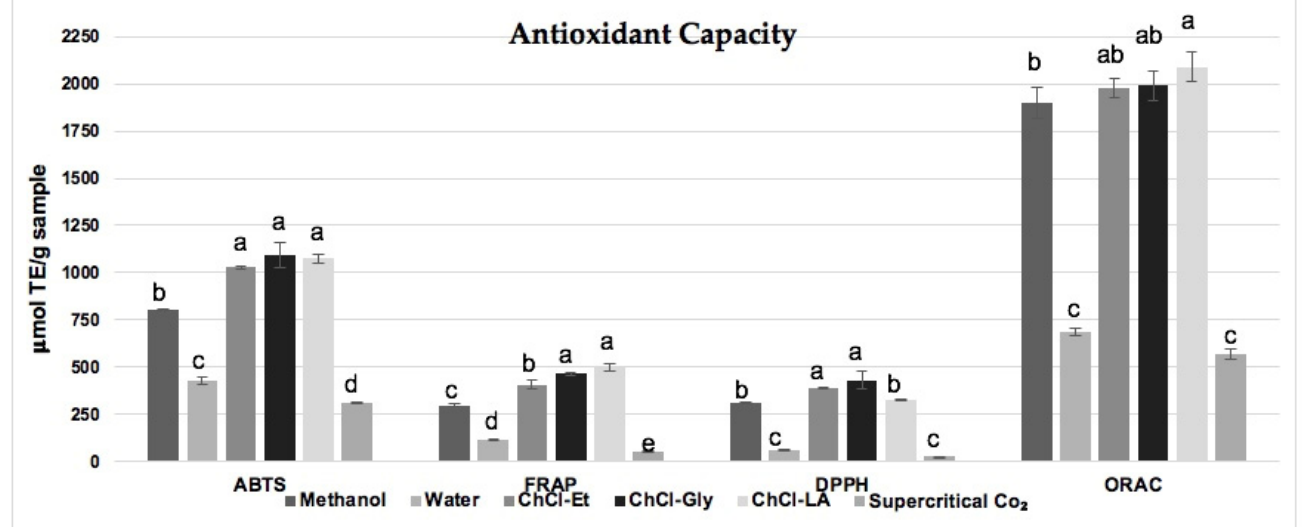
Figure 1. Antioxidant capacity of different oregano extracts ( Lippia graveolens ) by ABTS •+ , FRAP, DPPH • , and ORAC assays. Distinct letters in the same assay bars show the significant difference ( p < 0.05).